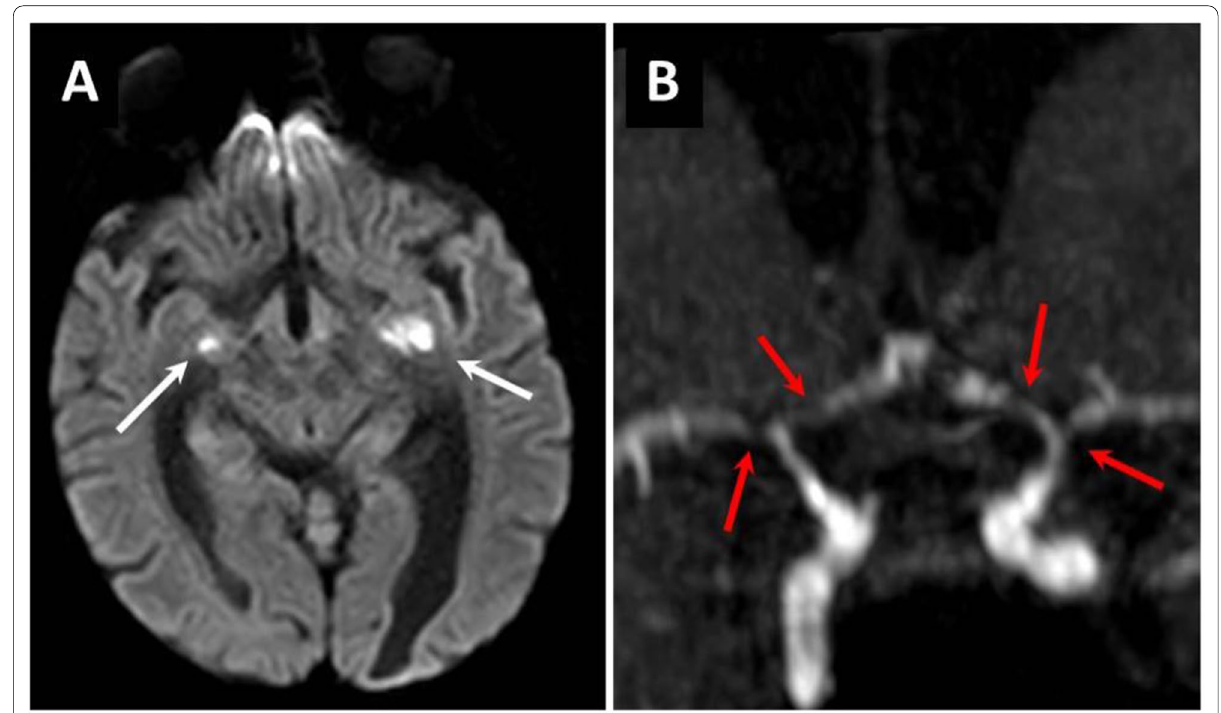
Fig. 1 Imaging characteristics of VZV encephalitis and vasculitis from brain MRI. A 18‑year‑old man was admitted to the ICU for fever, headaches and altered consciousness. He underwent a second kidney transplantation 2 years ago. The onset of neurologic symptoms started 2 days before ICU admission and invasive mechanical ventilation was implemented at day 2 for coma. The lumbar puncture revealed acute lymphocytic meningitis and the PCR for VZV was positive. Brain MRI showed multiple recent ischemic lesions of the brain parenchyma ( A : white arrows) and vasculitis with multiple stenosis of the circle of Willis arteries ( B : red arrows). He was treated with intravenous acyclovir 10 mg/kg/8 h and steroids (methylprednisolone 1 mg/kg). He recovered gradually and was extubated after 4 days of invasive mechanical ventilation. The patient was ultimately discharged alive 8 days after ICU